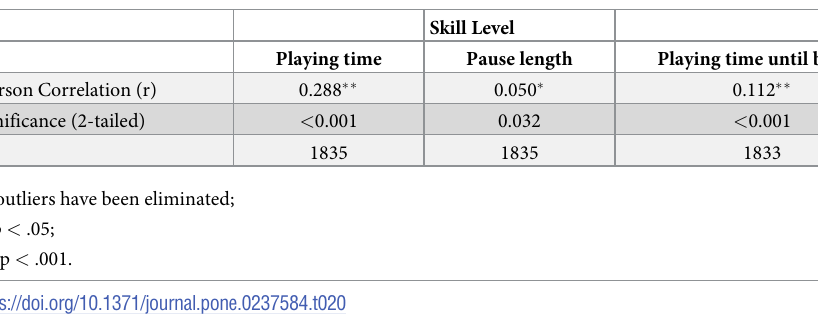
Table 20. Spearman rank correlation between skill level and playing time, pause length and playing time until break.